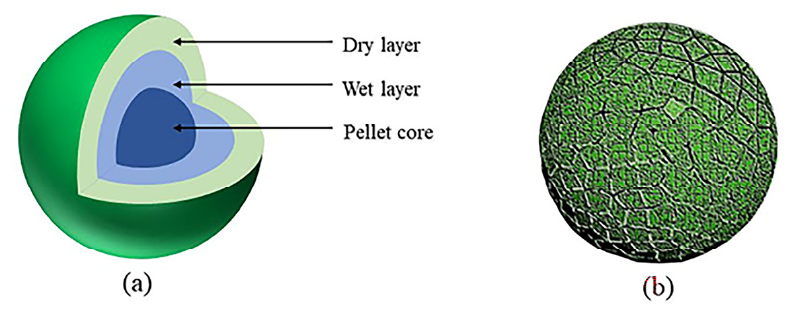
Figure 7. The 3D Model images of ( a ) a green pellet; ( b ) cracking pellet at high temperature.